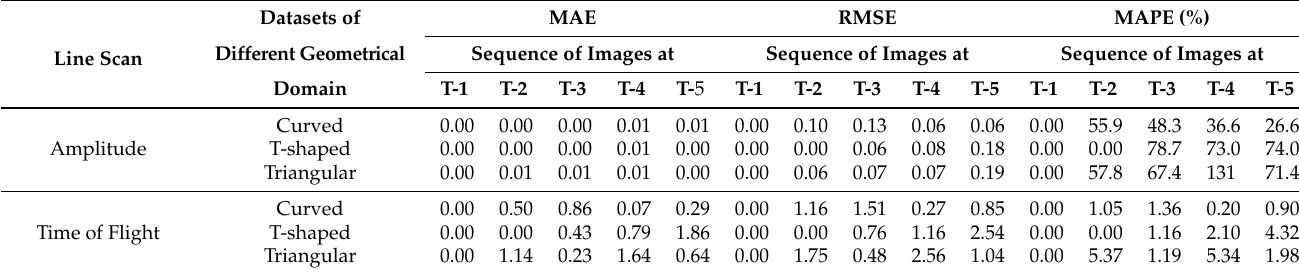
Figure 7. Line scans of reflected wave propagation with different geometrical domains: the FE and SDL modeled simulations are compared, quantitatively, by extracting the displacement values in each frame at x = 15 mm and y = 0 to 40 mm for different time instances, shown in Figure 6. ( a ) The line scans are extracted from Figure 6a for the curved domain, ( b ) shows the line scans are extracted from Figure 6b for the T-shaped domain, and ( c ) represents the line scans extracted from Figure 6c for the triangular domain. Table 2. Reflected wave propagation with different geometrical boundaries: the SDL model predicted simulation is compared with FE simulations. The MAE, RMSE, and MAPE methods are used for calculating the line-scan amplitude and time of flight (TOF) difference between SDL and FE, on the sequence of images at different time instances, shown in Figure